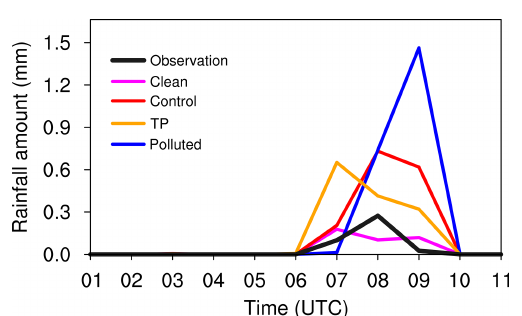
Figure 5. Time series of hourly precipitation rate (mm) in area A (31.4–31.5 ◦ N, 92.0–92.1 ◦ E) from 00:00 to 11:00UTC on 24 July